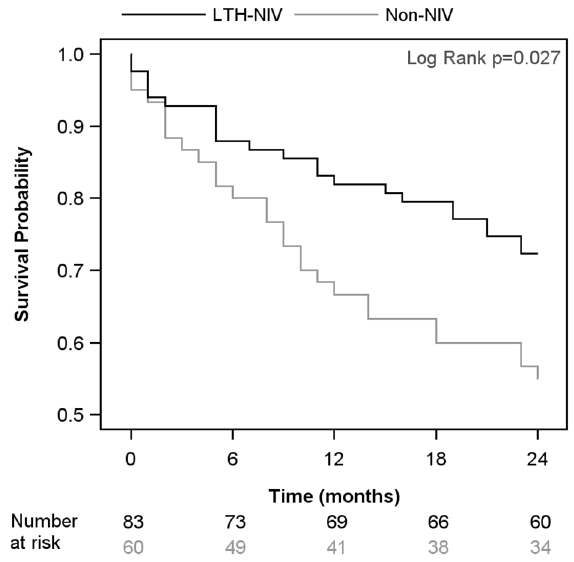
Figure 4. Comparison of survival curves between LTH-NIV patients and Non-NIV patients.